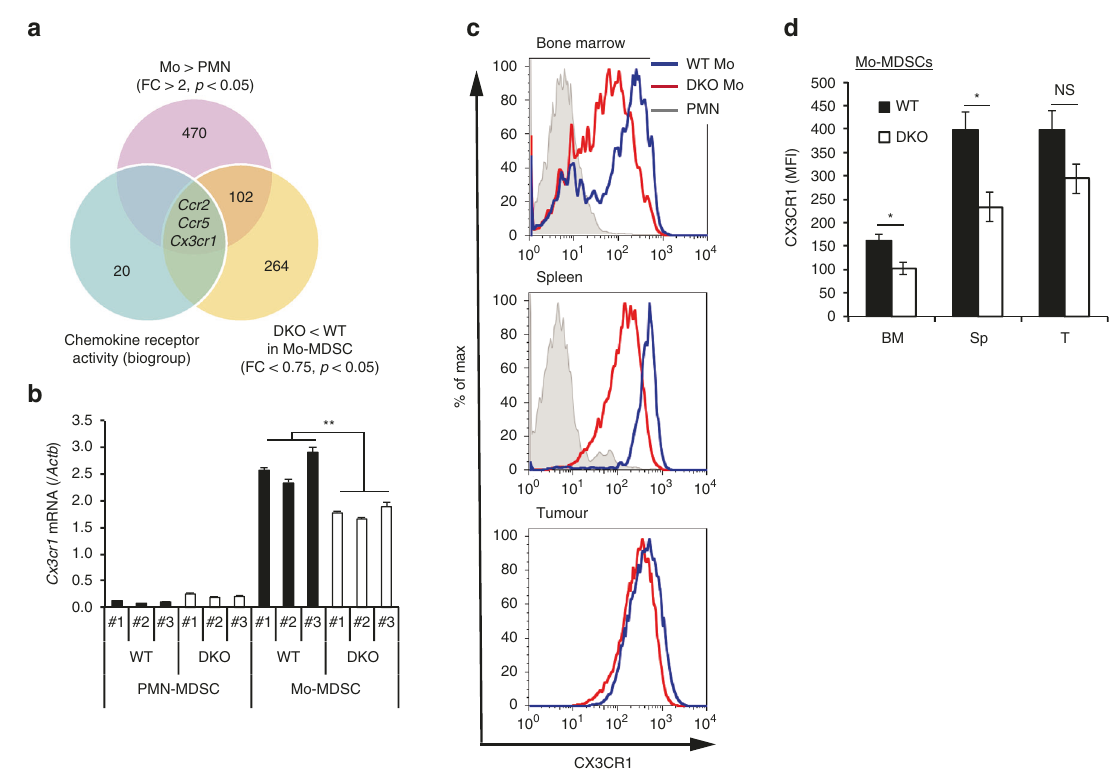
Fig. 3 CX3CR1 expression is decreased in Mo-MDSCs in p16/p21-DKO mice. a Identi fi cation of the factor regulating p16/p21-dependent Mo-MDSC accumulation using RNA-sequencing data analysis; the Venn diagram shows the numbers of genes overexpressed in Mo-MDSCs compared with those in PMN-MDSCs (fold change > 2, p < 0.05) and downregulated in DKO Mo-MDSCs compared with WT Mo-MDSCs (fold change < 0.75, p < 0.05) categorised under chemokine receptor activity (biogroup). b Cx3cr1 mRNA expression in PMN- and Mo-MDSCs from WT or p16/p21-DKO mice ( n = 3), as determined by qRT-PCR. c Representative fl ow cytometry histograms showing CX3CR1 expression in PMN- and Mo-MDSCs in BM (left), spleen (middle), and tumour (right) from WT and p16/p21-DKO mice 3 weeks after SCT cell injection. d Mean fl uorescence intensity (MFI) of CX3CR1 expression in Mo- MDSCs shown in c ( n = 5); data are presented as the mean ± SEM. The statistical signi fi cance was determined by Student ’ s t- test; * p < 0.05 and ** p